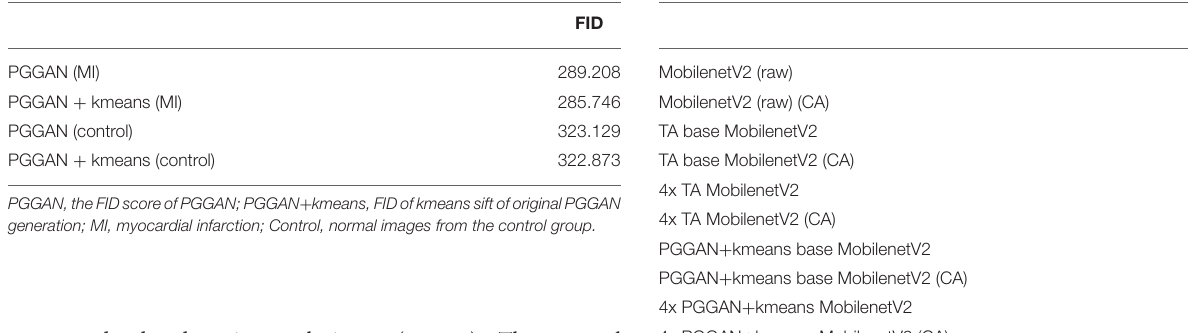
TABLE 1 | Generation of FID score from PGGAN. TABLE 2 | Comparative analysis of various classification